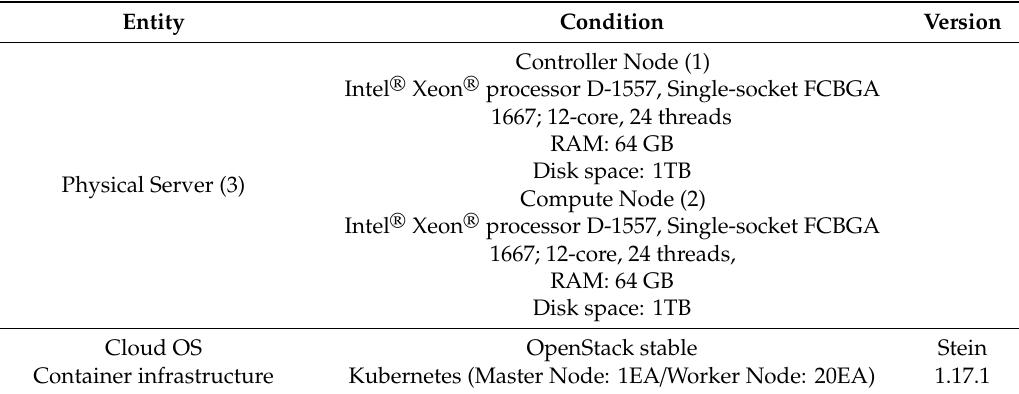
Table 3. Implementation s pecifications.